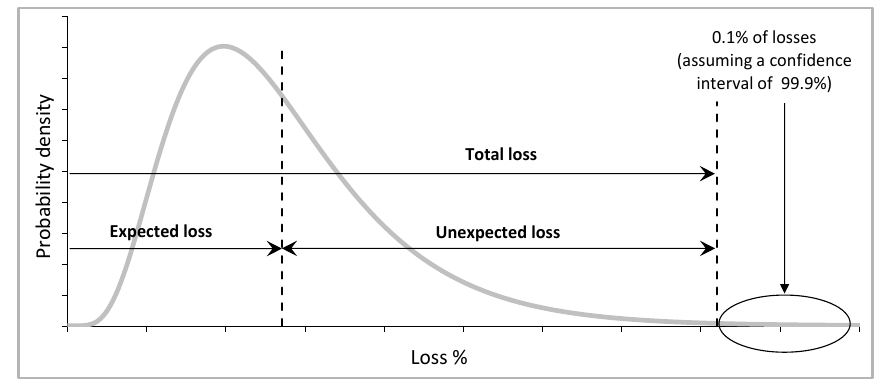
Hypothetical operational risk loss distribution showing expected losses and unexpected losses at the 99.9 th